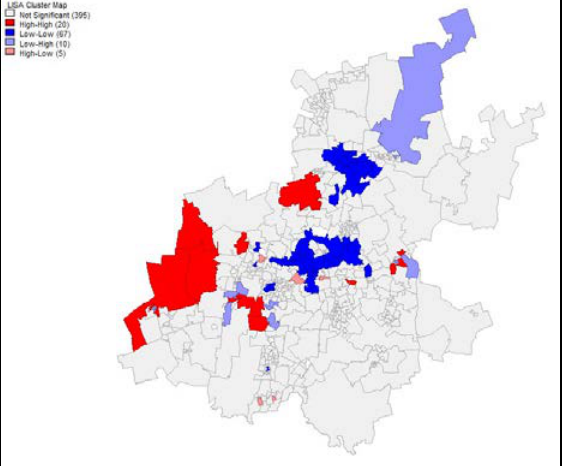
Figure 9. Cluster map of Headcount (%) in 2011